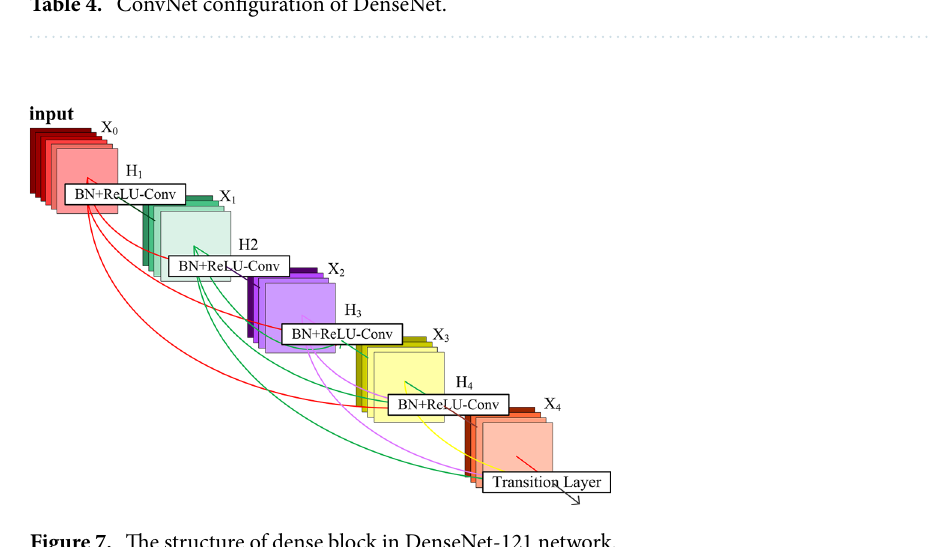
A stack of conv. layers is followed by the three Fully-Connected (FC) layers: the first two have 4096 chan- nels each, the third performs 2-way metastasis classification and thus contains 2 channels (one for each class). The final layer is the soft-max layer. The configuration of the fully connected layers is the same in all networks. The L2 regularization is introduced in VGG-7 to reduce overfitting, which is defined as follows.